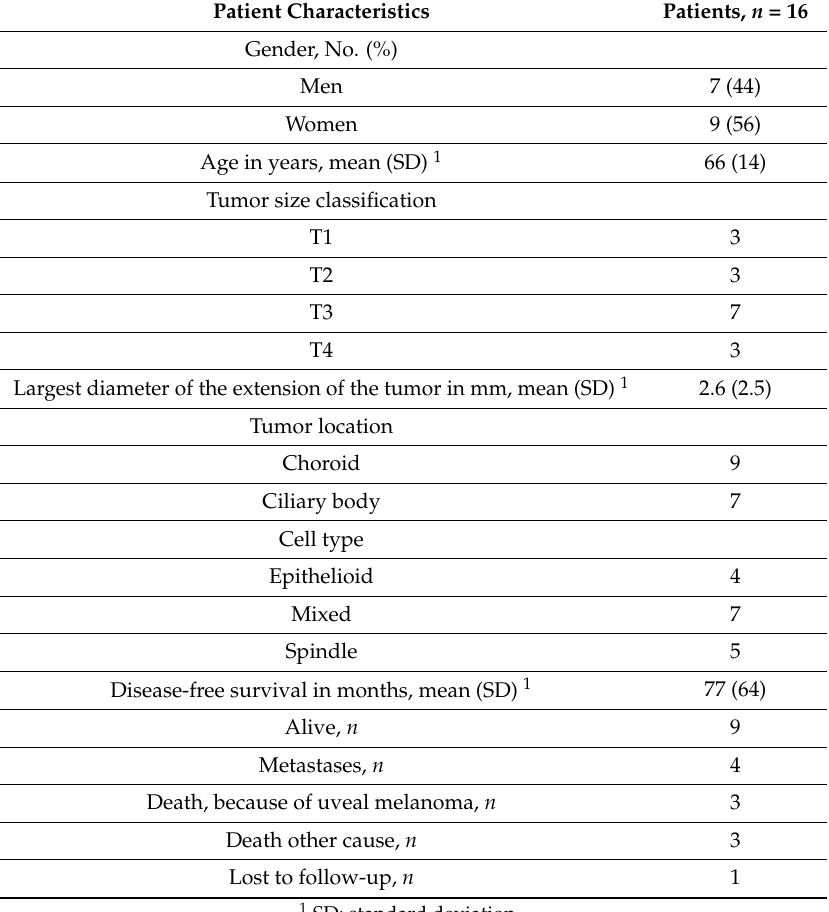
Table 1. Baseline patient